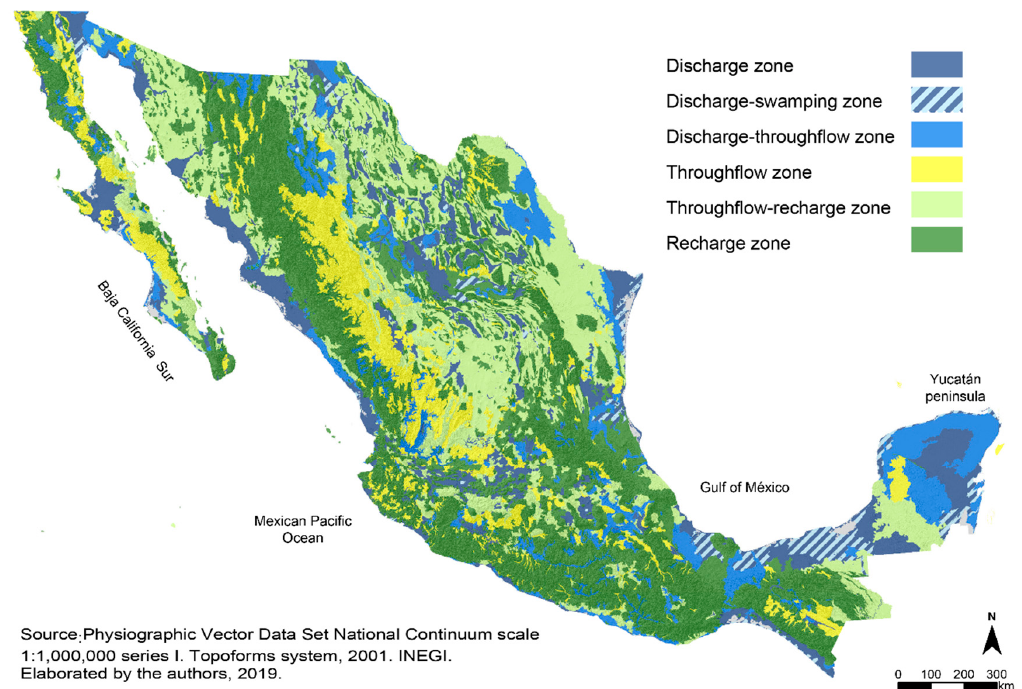
Figure 2. Hydrogeological association of regional topoforms.